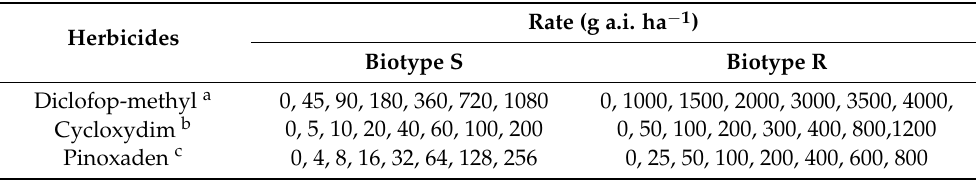
Table 4. Herbicide treatments for dose–response assays in Phalaris